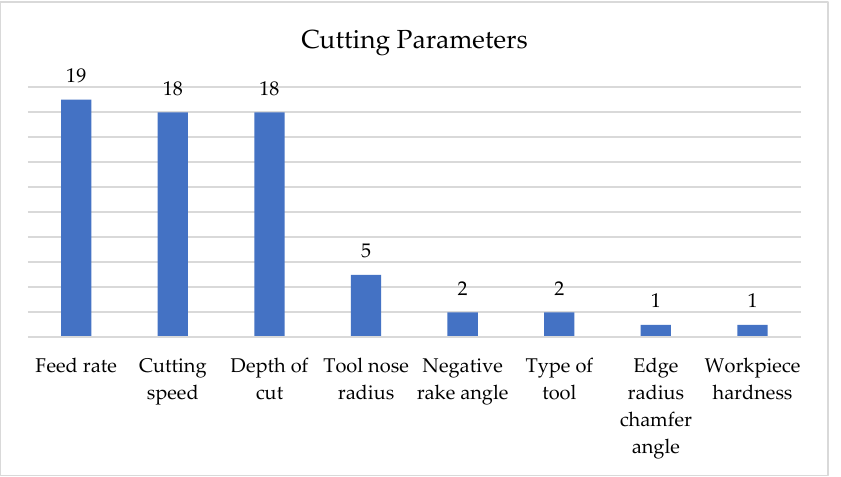
Figure 2. The frequency rates of the cutting parameters used when turning 52100 bearing steel.